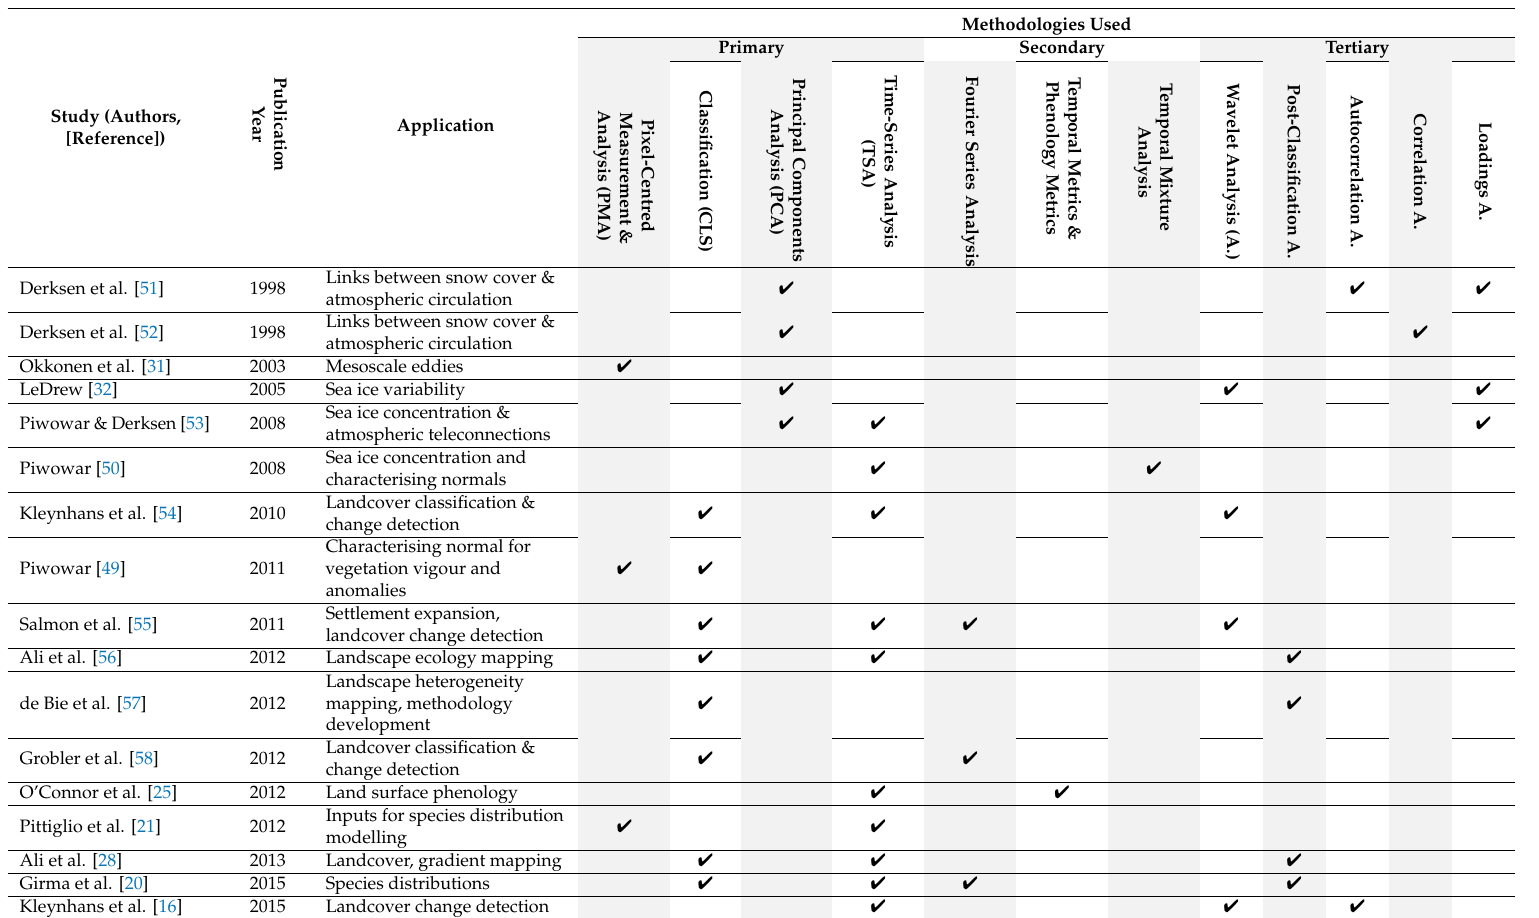
Table 2. A sample of hypertemporal studies showing the range of hierarchically arranged applications, and range of data processing methodologies. The hierarchy is aligned with that proposed by Piwowar & LeDrew [1]. Primary techniques are more likely to be most useful for general explorations of the data’s temporal nature. These primary techniques host the four methodology categories discussed in this paper (PMA, PCA, CLS, and TSA). Secondary functions are more helpful in explaining the dataset’s nature, whilst tertiary functions are applied pre- or post-processing, and often facilitate interpreting the primary analysis outputs.